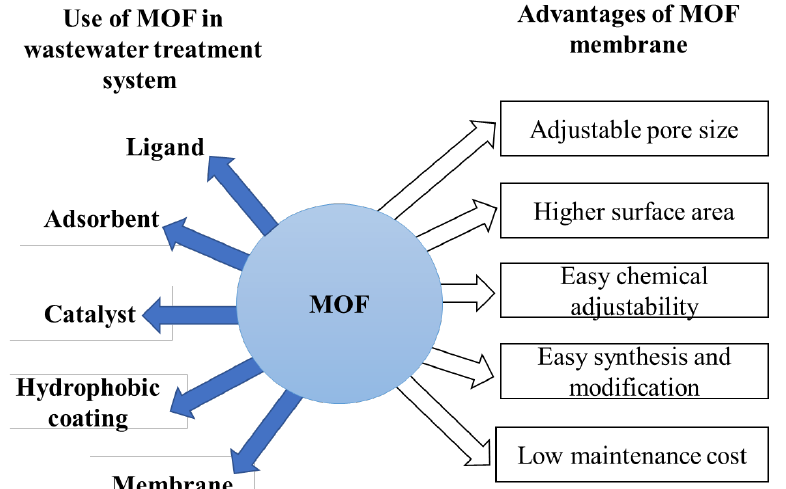
Figure 6. Use of a MOF during wastewater treatment and its